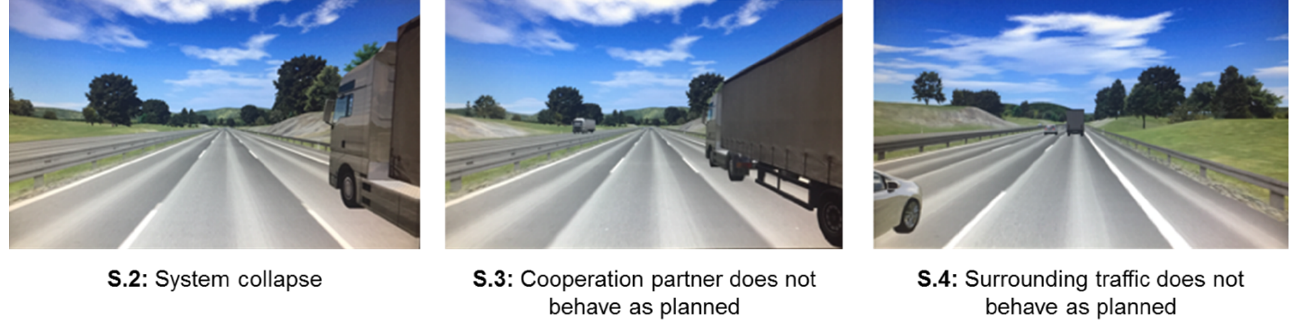
Figure 4. Timing of the abort situations S2–S4 from the truck driver’s perspective.